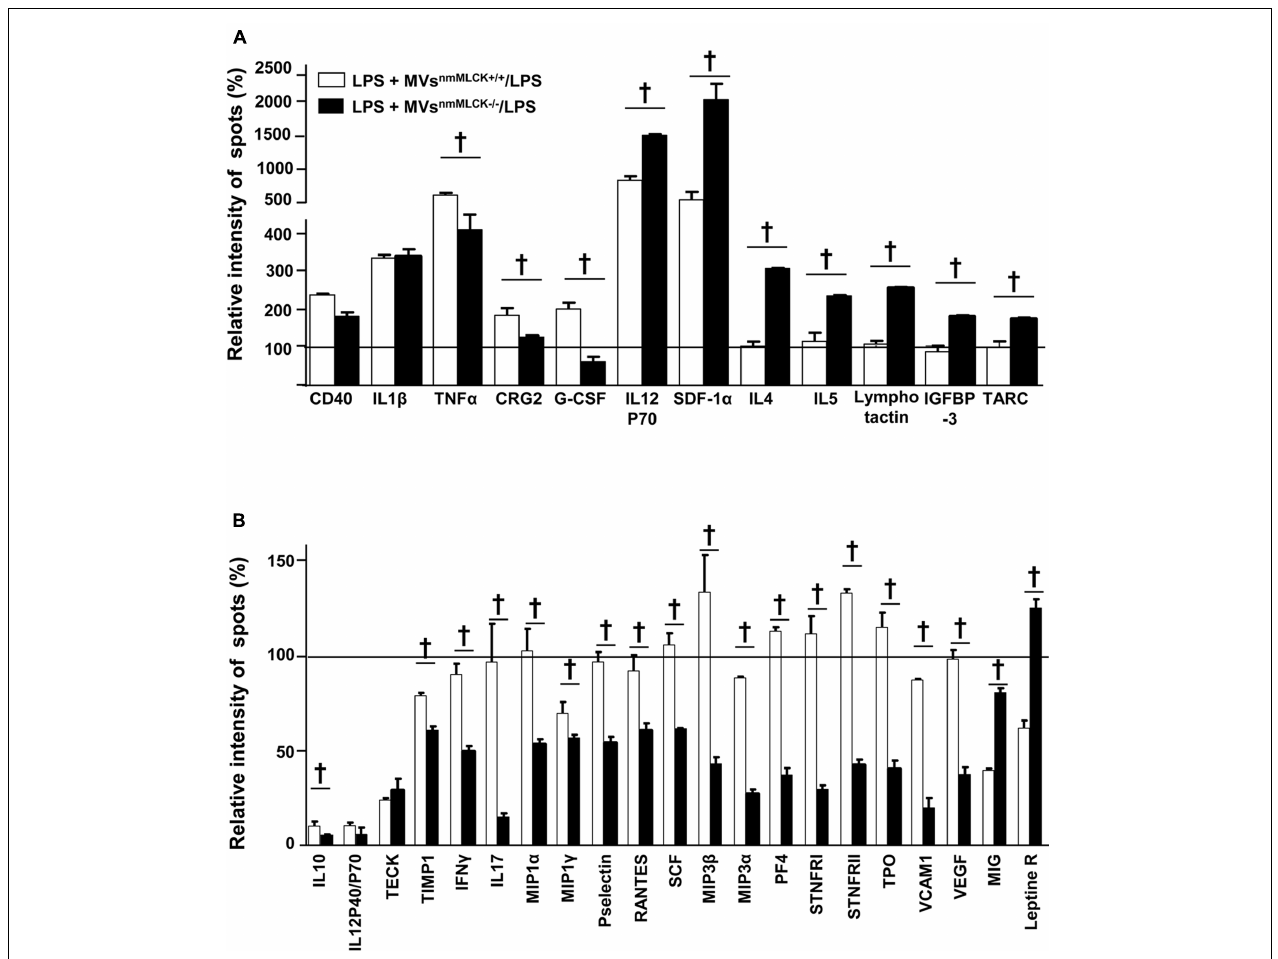
FIGURE 3 | Microvesicles from non-muscular myosin light chain kinase-deficient mice (MVs nmMLCK − / − ) increase anti- inflammatory and reduce pro-inflammatory secretome of aortic endothelial cells (AoECs). Primary AoECs from wild type mice were treated for 24 h with MVs nmMLCK + / + or MVs nmMLCK − / − in the absence or in the presence of LPS (10 µ g/ml). Cytokine production was evaluated by Ray Bio Mouse Cytokine Antibody Array 3 kit (Supplementary Figure 1A for more details). Data represent the mean ± SEM ( n = 3–5). (A,B) Histograms show the cytokine ratio between either LPS + MVs nmMLCK + / + -treated versus LPS-treated cells or LPS + MVs nmMLCK − / − -treated versus LPS-treated cells. Black line represents no change in cytokine production between treatments. Results are expressed as a percentage of relative intensity of spots (%). Data represent the mean of three experiment ( n = 3–5). † P <